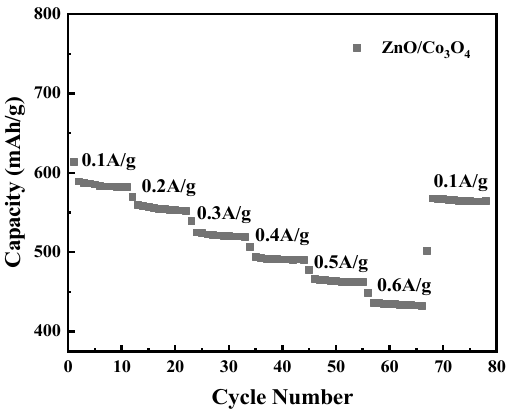
Figure 8. The rate capability at various current densities of ZnO/Co 3 O 4 .